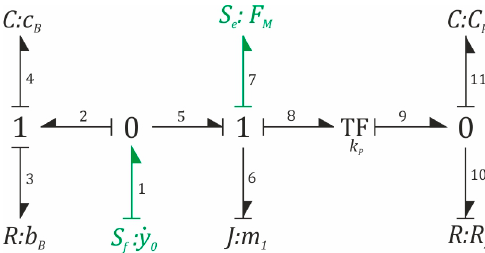
Figure 1. Analyzed design of energy harvesting systems with the magneto-piezo-elastic beam. Considered potentials are presented in ( a ) two-well and ( b ) three-well designs, respectively. The additional vertical arrow symbolizes the excitation contact force, F 1 , acting on the beam.